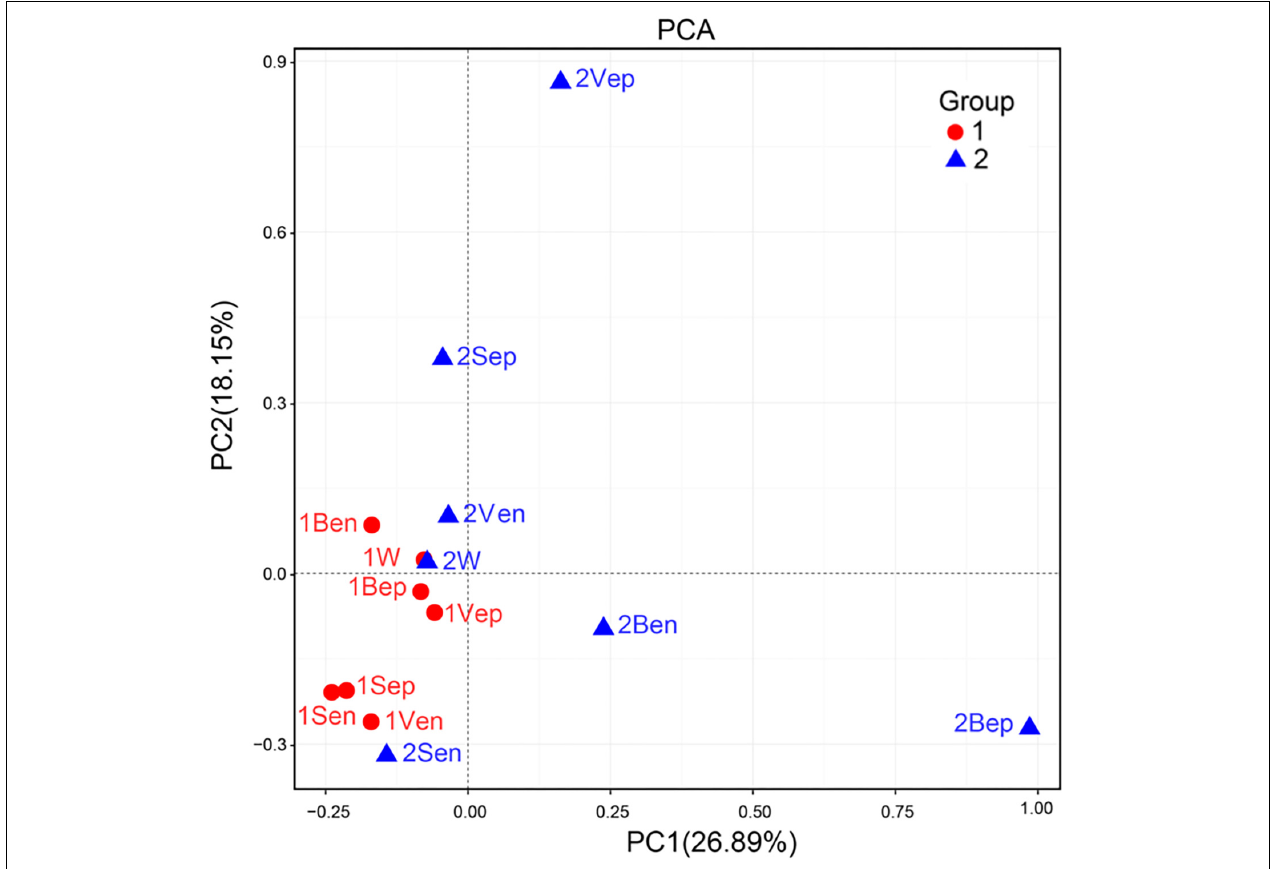
FIGURE 9 | Principal Component Analysis (PCA) of the bacterial communities from all samples based on Euclidean distance at genus